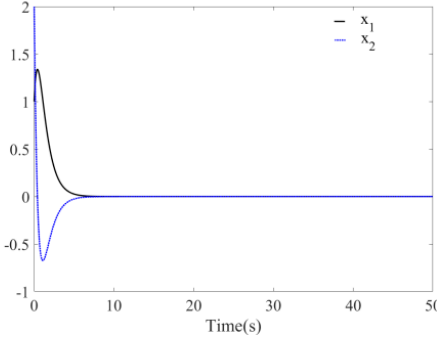
Figure 11. Time response of system with unknown parameters (without disturbance, λ 1 = − 2).